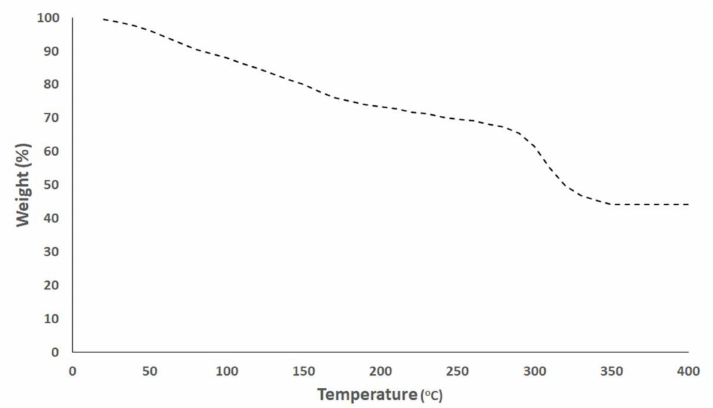
Figure 5. Thermal gravimetric analysis (TGA) thermogram of Pt–Pd NPs synthesized by P. harmala seed alkaloid fraction.